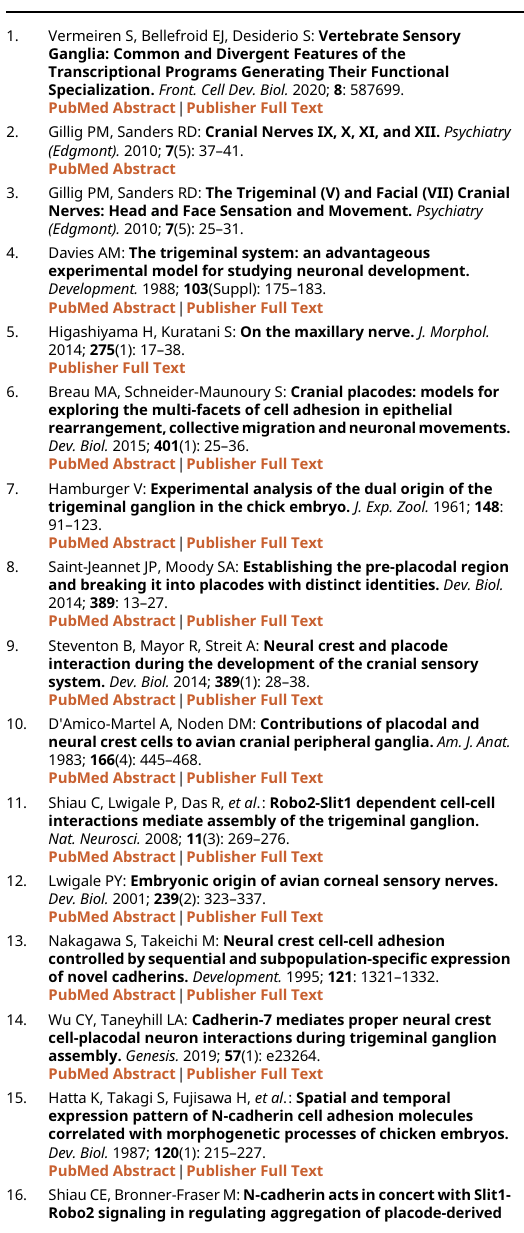
(cid:129) Table 1: Excel file showing quantification of GFP fluorescence after co-transfection of complementary, split GFP constructs with the same or different cadherin in vitro (cid:129) Table 2: Excel file showing quantification of GFP fluorescence after co- or sequential electroporation of complementary, split GFP constructs with the same or different cadherin in vivo Data are available under the terms of the Creative Commons Attribution 4.0 International license (CC-BY